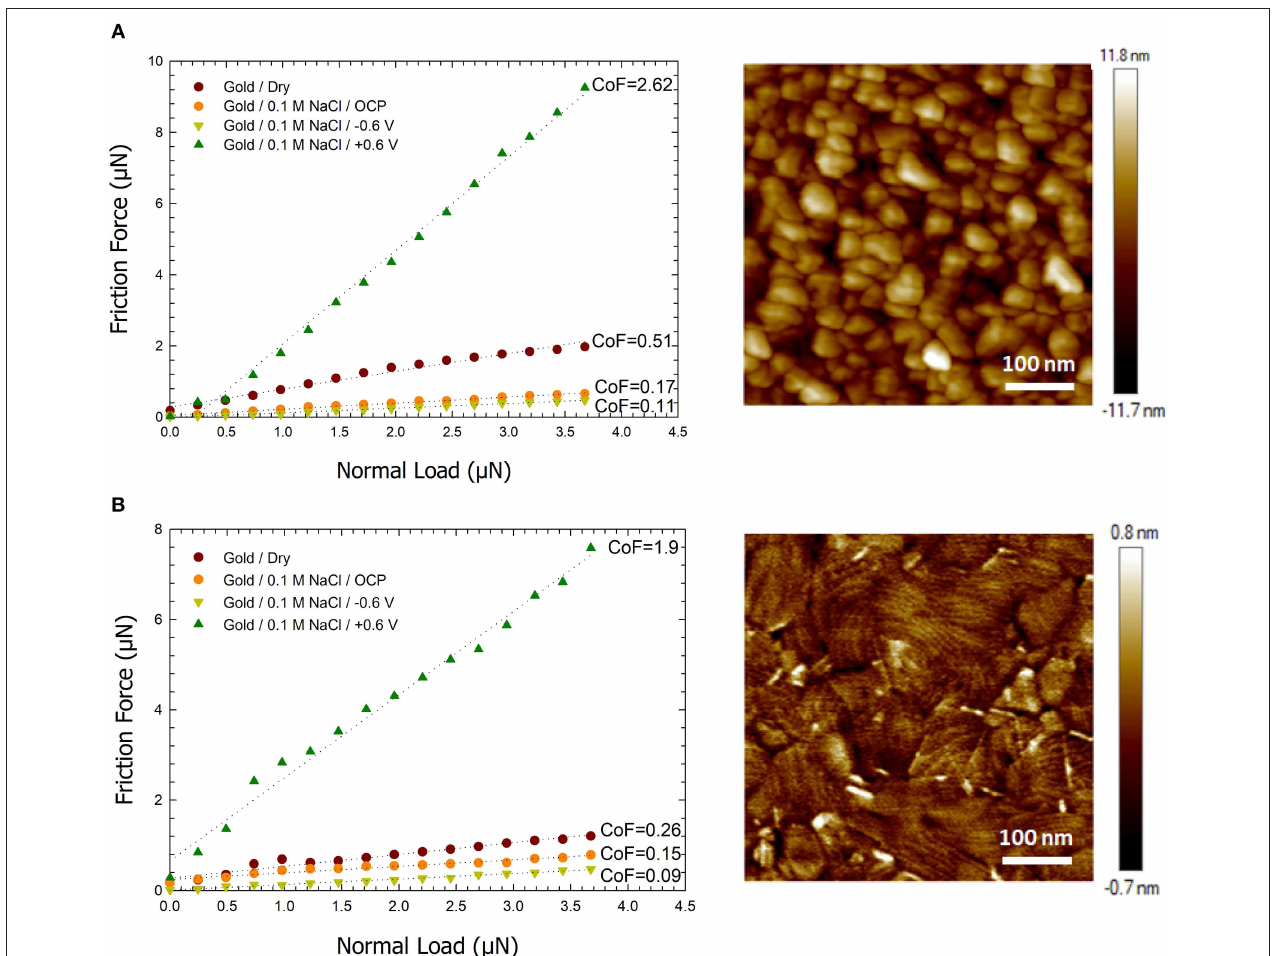
FIGURE 2 | Plots of the friction force vs. normal load for dry, open circuit, and applied potentials of − 0.6 and + 0.6V between a sharp AFM tip and (A) a gold surface formed by sputtering (B) an ultra-smooth Au surface formed by e-beam deposition. The images to the right are AFM height images of the corresponding gold surfaces. A scan size of 500nm and scan speed of 1 µ m. s − 1 was used for friction